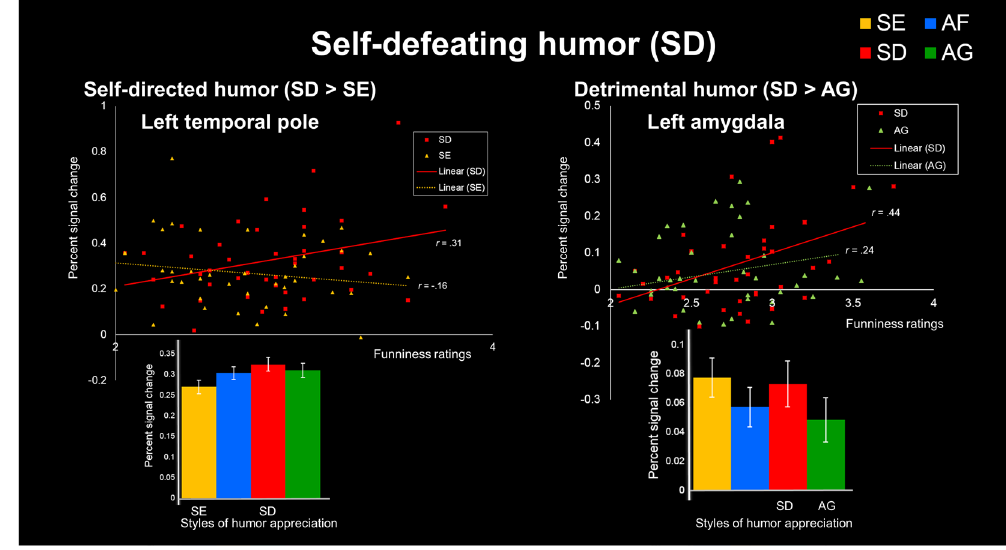
Figure 5. BOLD activity correlation with self-defeating humor appreciation. (Top left) Scatter plot illustrating the positive correlation between funniness ratings for self-defeating one-liners and activation of the left temporal pole (TP) ( r = 0.31, p < 0.05). Negative correlation between self-enhancing humor (SE) appreciation ratings and no significant activation of the left TP ( r = − 0.16, p > 0.05). (Bottom left) Percent signal change in relation to humor appreciation for processing of SD and SE in the left TP. (Top right) Scatterplot illustrating the positive correlation between funniness ratings for SD one-liners and activation of the left amygdala ( r = 0.44, p < 0.01). Positive correlation between aggressive humor (AG) appreciation ratings and no significant activation of the amygdala ( r = 0.24, p > 0.05). (Bottom right) Percent signal change in relation to humor appreciation for processing of SD and AG in the left